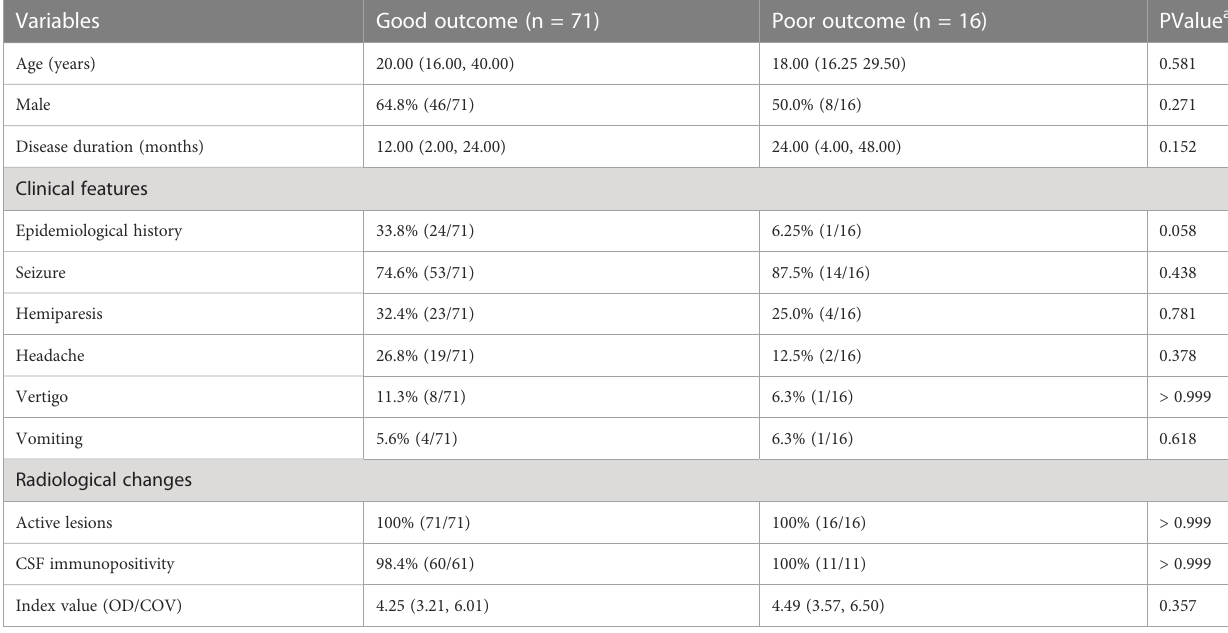
TABLE 3 Baseline characteristics of patients with different outcomes before treatment. Variables